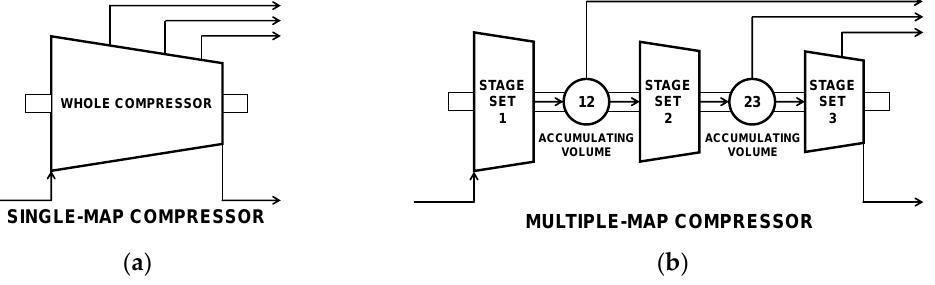
Figure 3. TGSim Plus™ compressor modelling. ( a ) Single-map compressor, ( b ) Multiple-map Figure3. TGSimPlus ™ compressormodelling. ( a )Single-mapcompressor, ( b compressor.